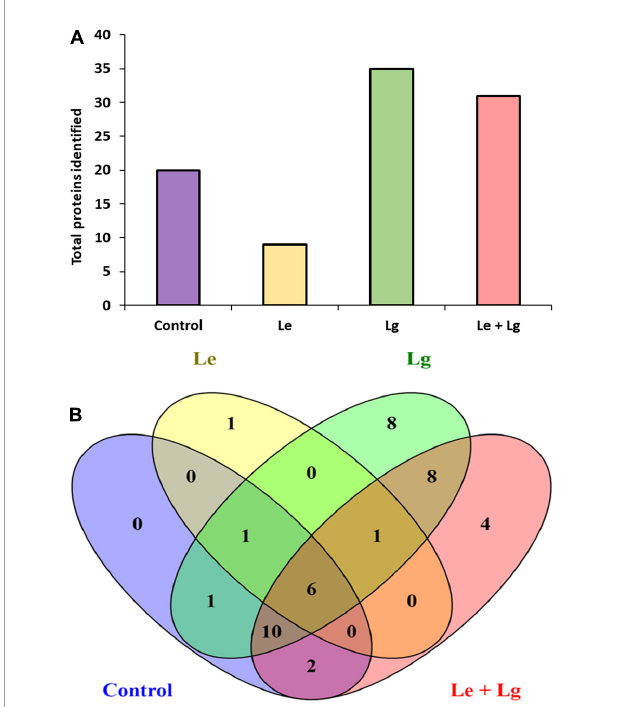
FIGURE3 Detection of proteins in the mycelia of B. cinerea in response to lemon and lemongrass EOs exposure. (A) Total number of proteins identified in the different treatments, and (B) Venn diagram illustrating the common and unique proteins identified in all treatments and